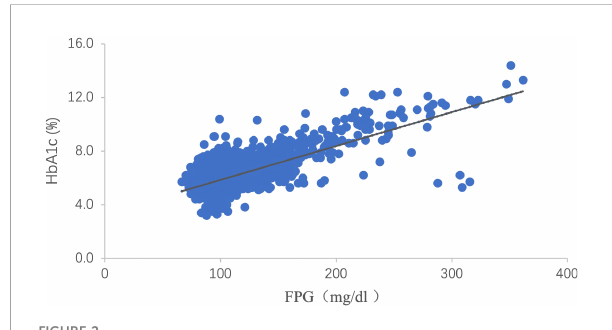
FIGURE 2 Scattergram of HbA1c versus FPG. There is a clear linear relation between HbA1c and FPG [HbA1c (%) = 3.335 + 0.025 FPG (mg/ dL), P < 0.001, R 2 = 0.528]. HbA1c: hemoglobin A1c; FPG: fasting plasma